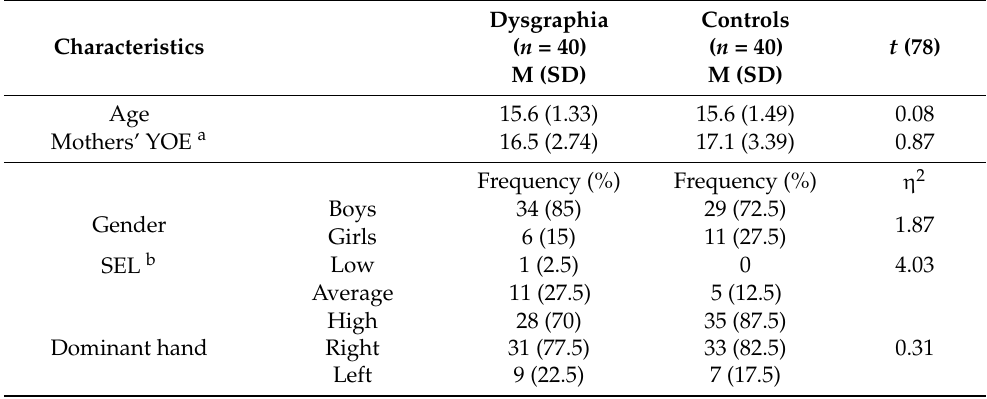
Table 1. Participants’ sociodemographic